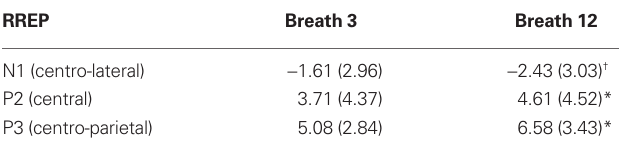
Table 2 | Mean (SD) amplitudes (μV) of the respiratory-related evoked potential (rrEP) for breath third and breath 12th during resistive load